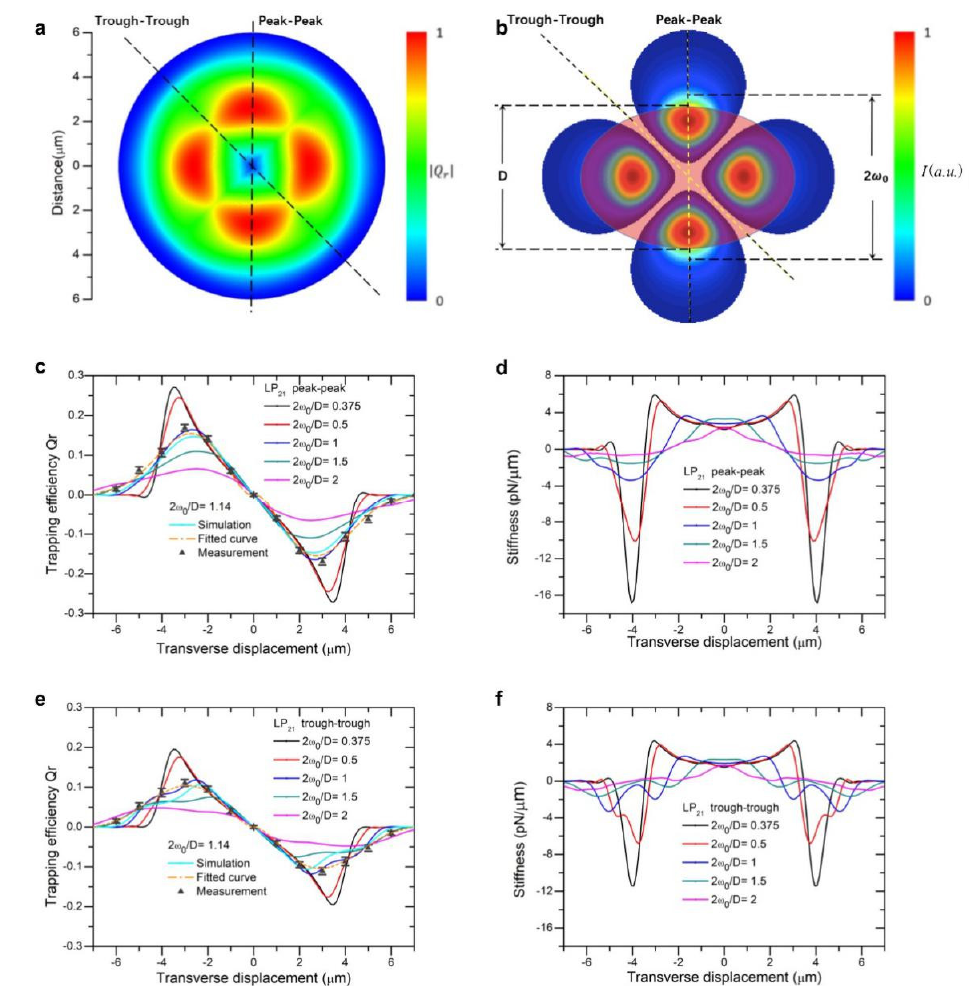
Figure 2. Landscape of trapping force of an LP 21 beam. ( a ) Normalized 2D trapping force distribution of LP 21 mode; ( b ) Cross-sectional view of a spheroid cell trapped by an LP 21 beam; ( c ) LP 21 beam trapping efficiency vs. displacement curves along the peak-to-peak direction; ( d ) LP 21 beam trapping stiffness vs. displacement curves along the peak-to-peak direction; ( e ) LP 21 beam trapping efficiency vs. displacement curves along the trough-to-trough direction; ( f ) LP 21 beam trapping stiffness vs. displacement curves along the trough-to-trough direction.